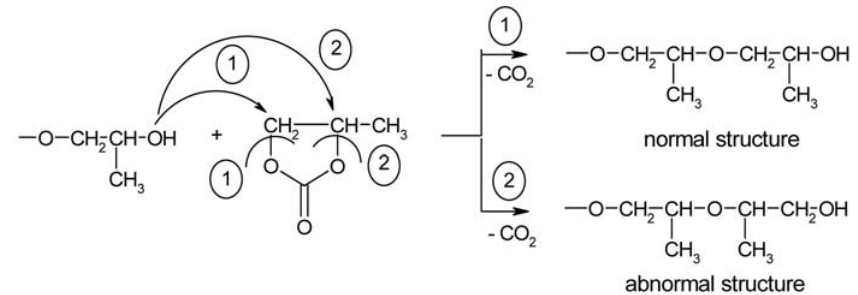
Scheme 4. PC ring-opening